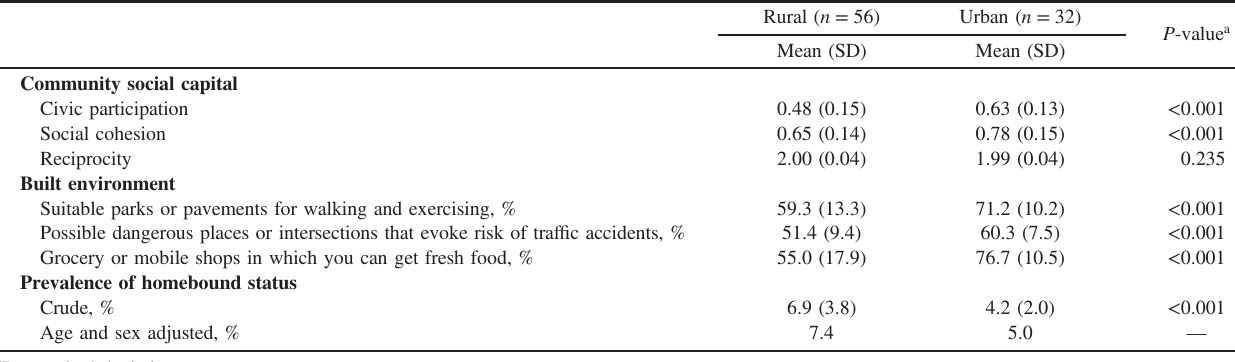
Table 1. Community characteristics di ff erences by rural and urban areas